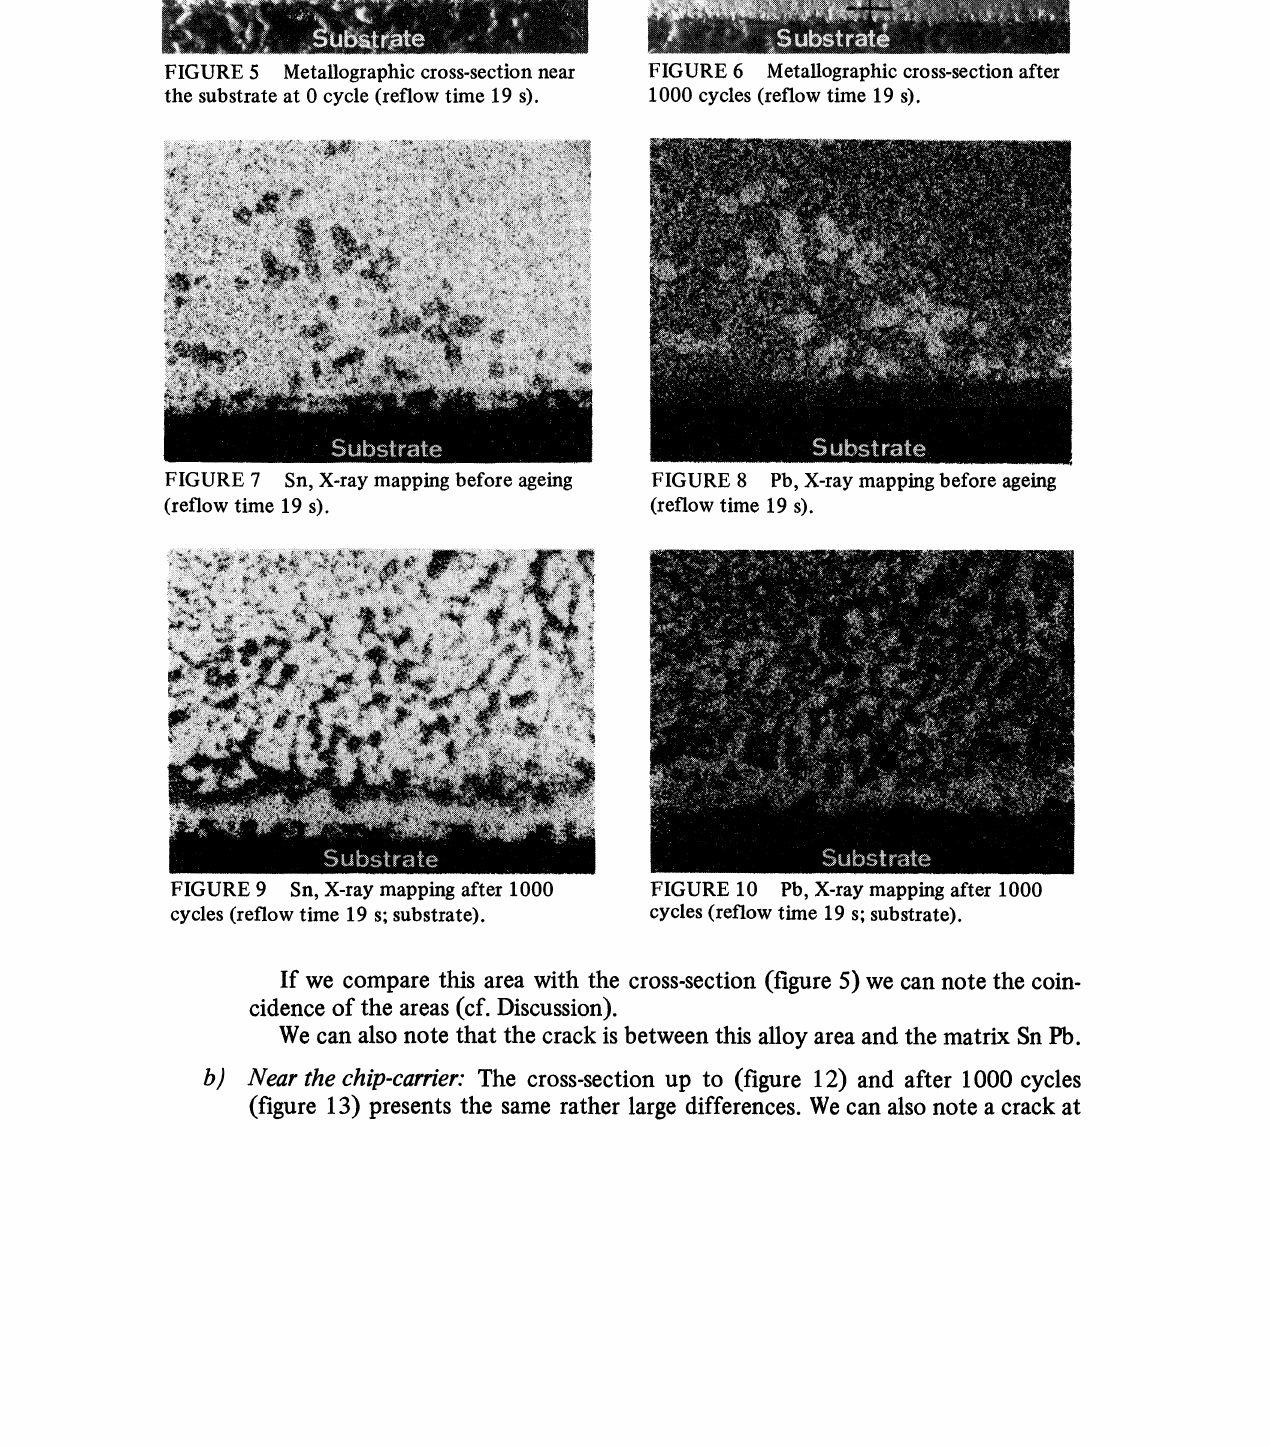
FIGURE 6 Metallographic cross-section after 1000 cycles (reflow time 19 s).